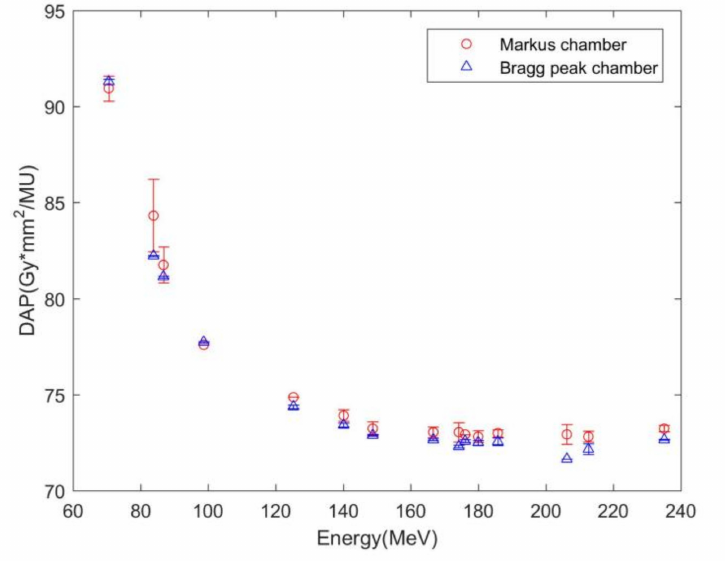
Figure 6. Comparison of DAP determination with Markus chamber and Bragg peak